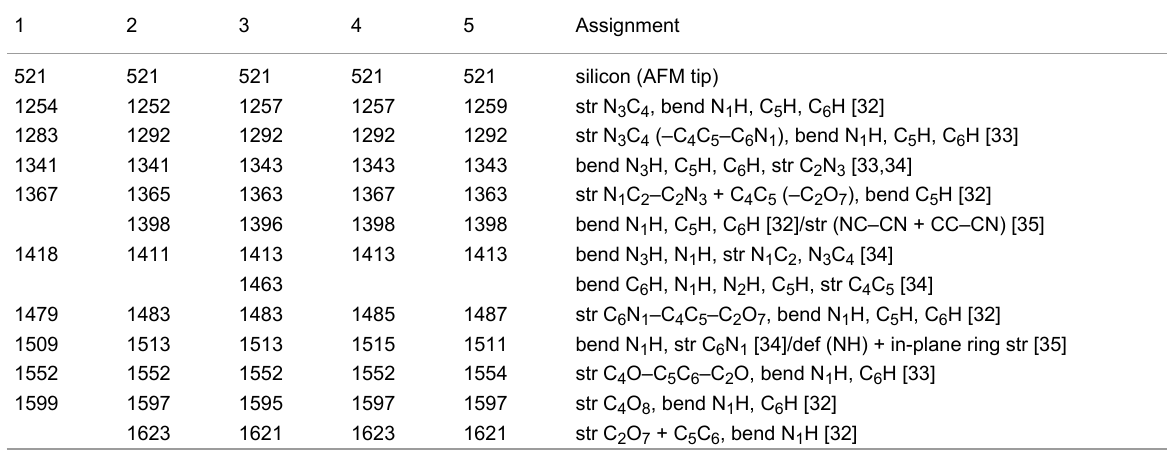
a Abbreviations: str, stretching; bend, bending; def,